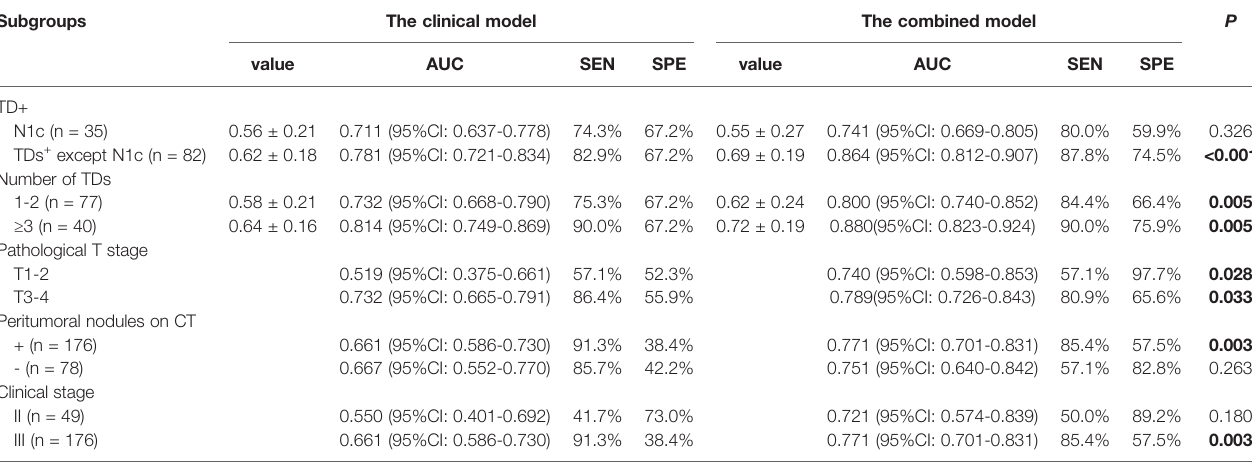
P value: comparison between the clinical model and combined model. P values less than 0.05 are shown in